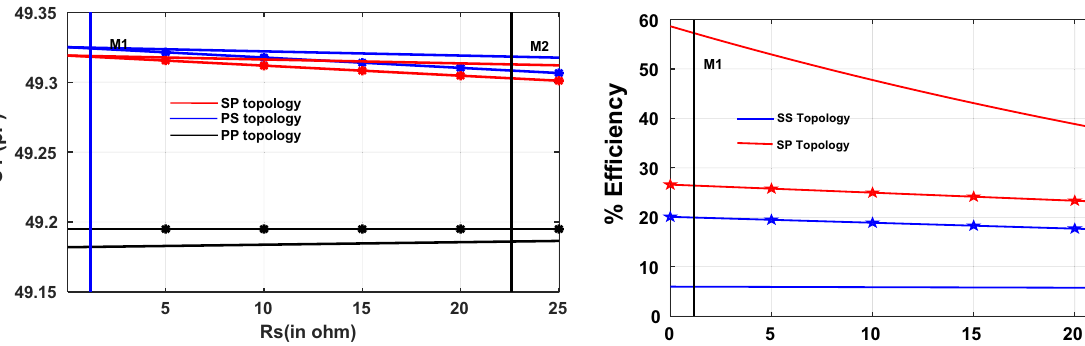
Figure 5: E ffi ciency vs e ff ect of resistance R 2 at di ff erent load: R = 50 Ω and R = 200 Ω L L